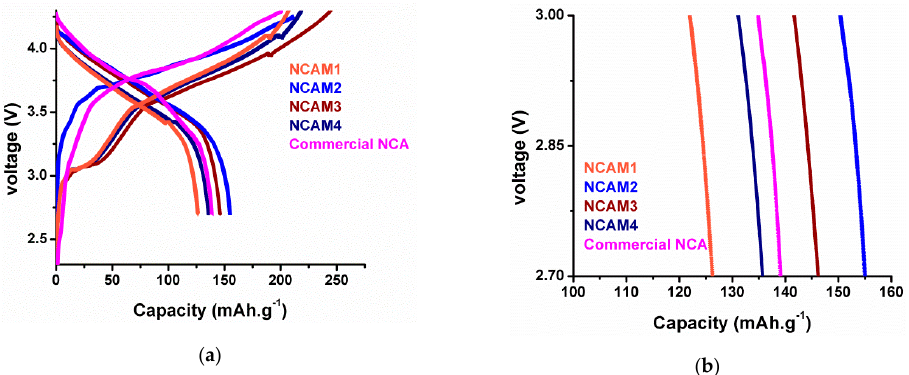
Figure 14. ( a ) Charge—discharge curve of as-prepared NCA samples at various precursor solution concentrations and ( b ) magnified portion of the graph.